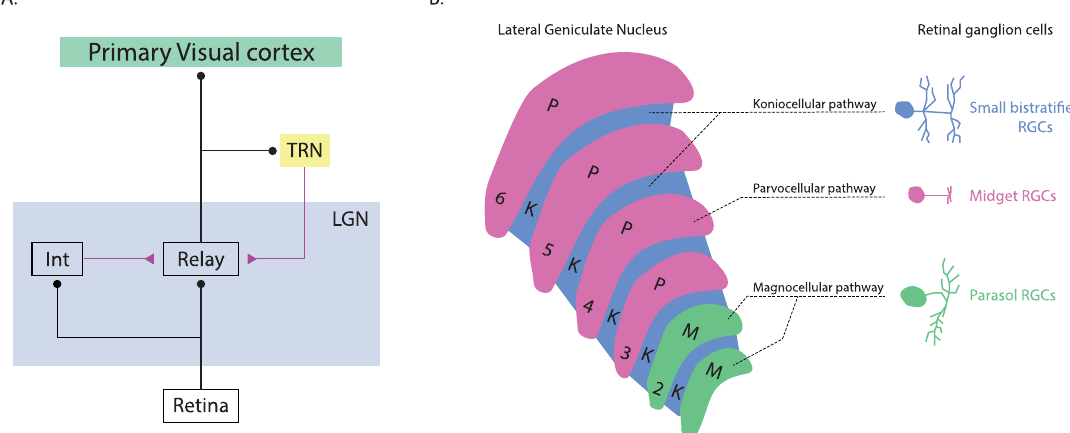
Fig. 4 Structure of the LGN with three distinct layers. Simpli fi ed diagram of visual thalamic circuitry and the LGN. A Diagram of feedforward and feedback inhibitory pathways that in fl uence LGN RCs. Excitatory inputs are indicated in purple. Inhibitory inputs are indicated in black. TRN: thalamic reticular nucleus; LGN lateral geniculate nucleus; Int LGN interneuron. Modi fi ed from Casagrande & Xu 129 . B LGN diagram with ganglion cells type. RGCs retinal ganglion cells. Redrawn from Kim et al. 141